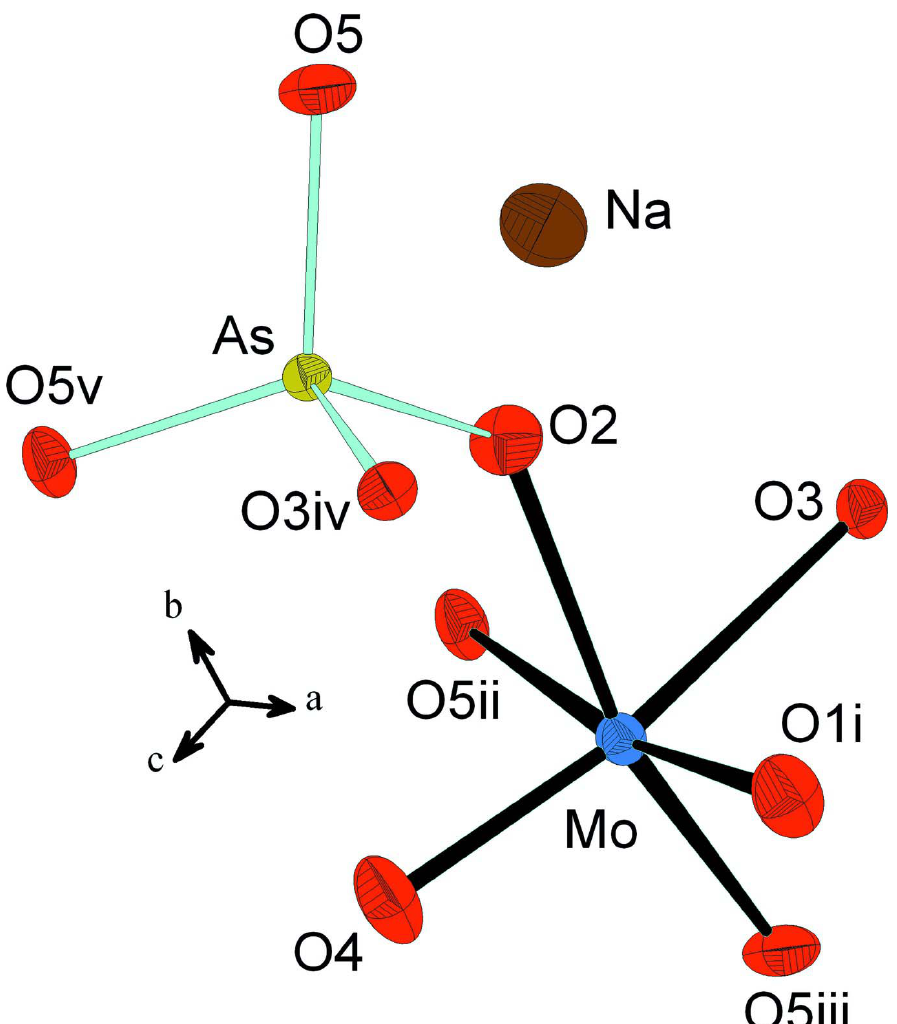
AsO . [Code de sym'etrie: voir table 2 4